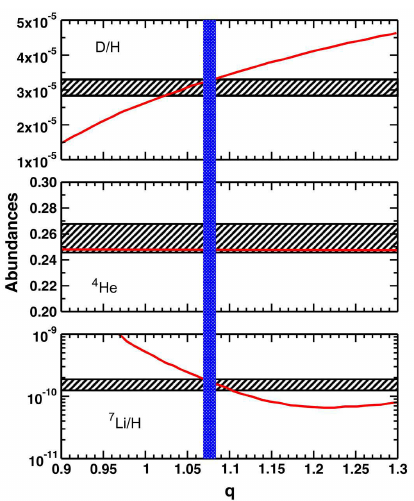
Figure 7: Predicted abundances D, 4 He and 7 Li (red curves) as a function of the Tsallis parameter q [75]. The observed primordial abundances including 1 σ uncertain- ties are indicated by hatched horizontal bands [23, 39, 76]. The vertical (blue) band refers to the parameter q within the interval 1 . 069 < q < 1 .